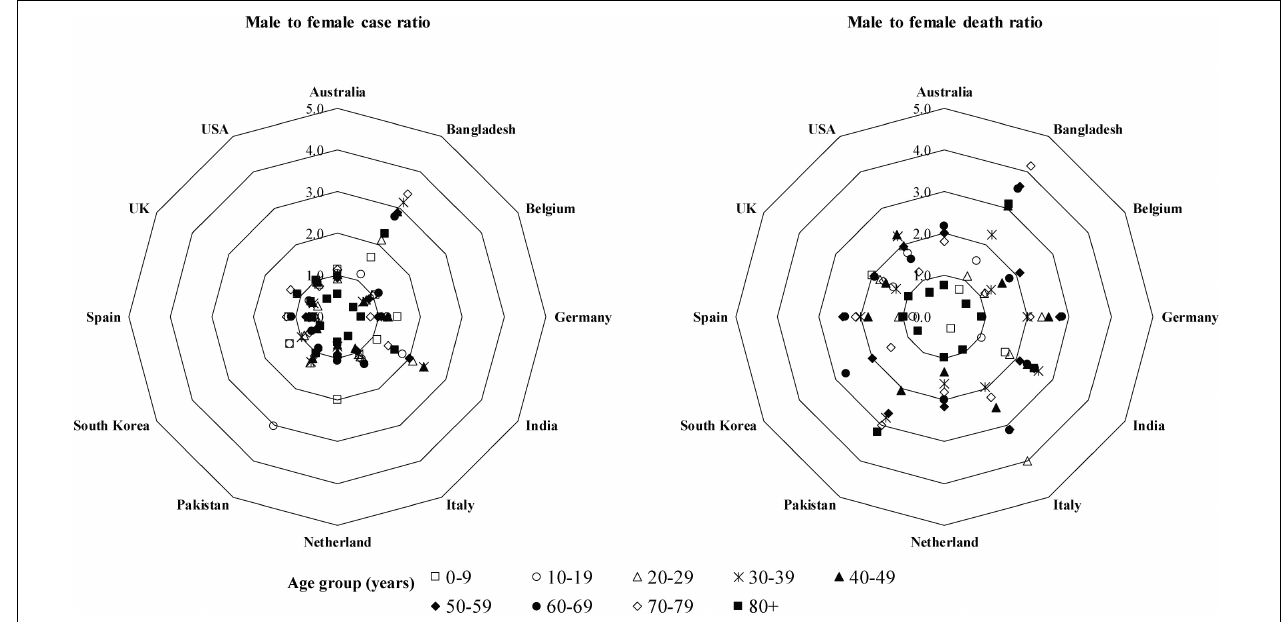
FIGURE 5 | Male-to-female case and death ratios at different age groups. The data were extracted from the following sources: Australia (https://www.health.gov.au/ news/health-alerts/novel-coronavirus-2019-ncov-health-alert/coronavirus-covid-19-current-situation-and-case-numbers#cases-and-deaths-by-), Bangladesh (https://www.who.int/docs/default-source/searo/bangladesh/covid-19-who-bangladesh-situation-reports/who-covid-19-update-32-20201005.pdf?sfvrsn=9ac4 1c99_2), Belgium (https://epistat.wiv-isp.be/covid/), Germany [https://www.rki.de/EN/Content/infections/epidemiology/outbreaks/COVID-19/COVID19.html, https://www.statista.com/statistics/1105512/coronavirus-covid-19-deaths-by-gender-germany/(Survey time period as of October 7, 2020)], India (Gupta et al., 2020; https://m.hindustantimes.com//india-news/), Italy (https://www.epicentro.iss.it/coronavirus/bollettino/Bollettino-sorveglianza-integrata-COVID-19_27-ottobre- 2020.pdf, https://dc-covid.site.ined.fr/en/data/italy/), Netherlands (https://data.rivm.nl/covid-19/), Pakistan (https://globalhealth5050.org/the-sex-gender-and- covid-19-project/), South Korea (http://www.kdca.go.kr/cdc_eng/), Spain